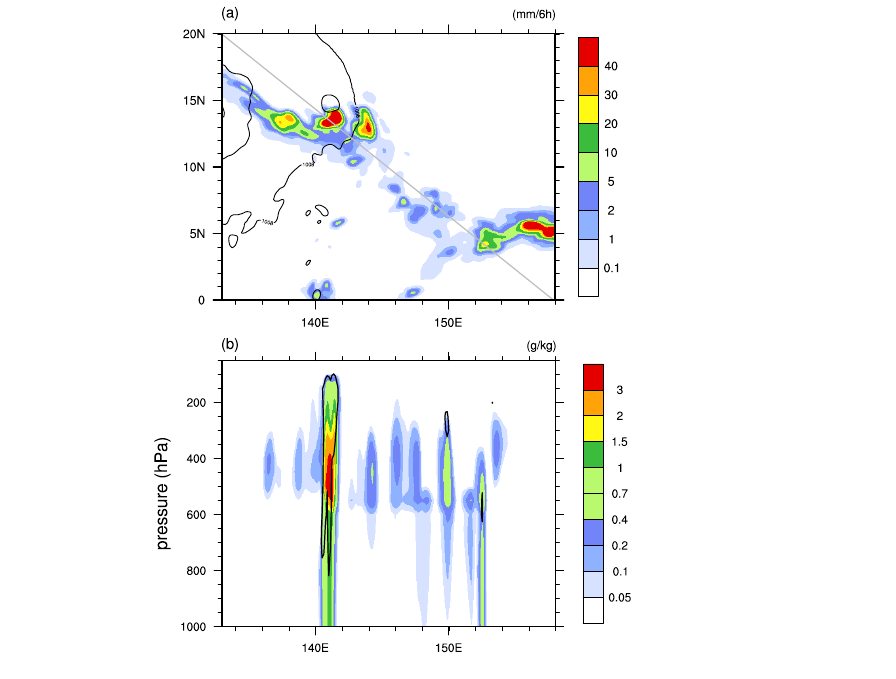
Figure 2. ( a ) Horizontal distribution of the six-hourly grid-scale precipitation rate (shaded; mm 6 h − 1 ) and ( b ) the vertical distribution of the mixing ratio of rain and snow (shaded; g kg − 1 ) across the gray transect in ( a ) at 1200 UTC on 24 July 2017 from the CTL experiment. Sea-level pressure contours (4 hPa interval) are added in ( a ), and contours of vertical velocity of 0.4 m s − 1 are added in ( b ).